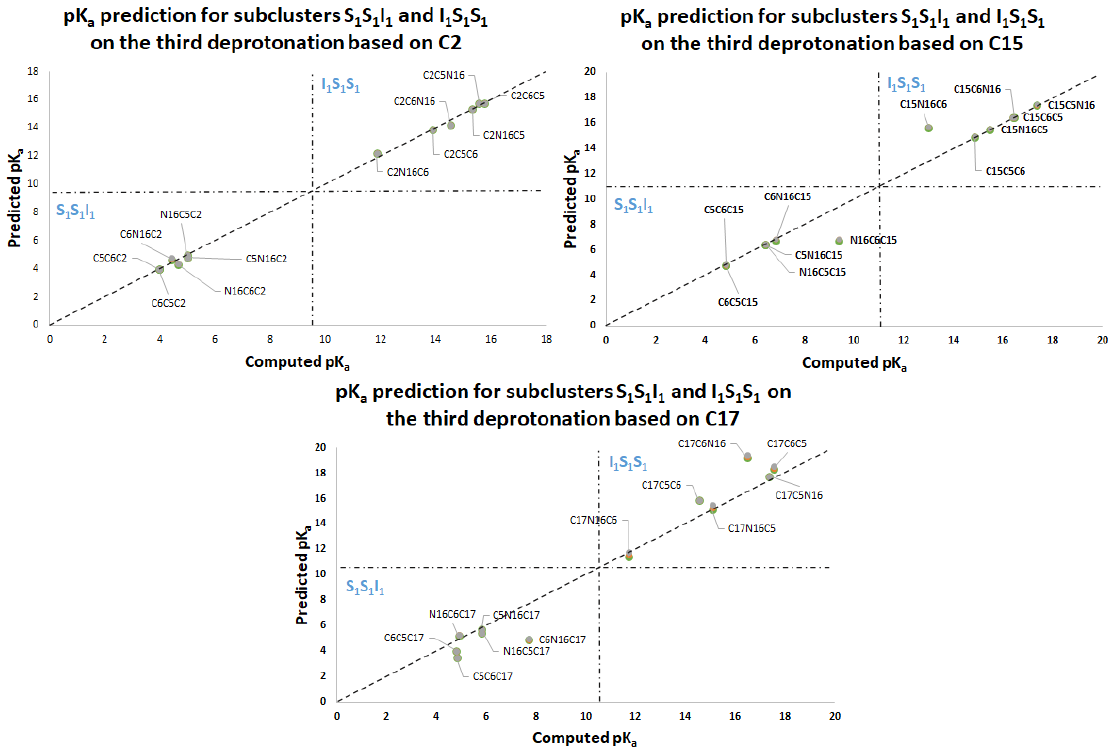
Figure 17. pK a prediction for the third deprotonation on the subclusters S 1 S 1 I 1 and I 1 S 1 S 1 based on C2, C15, and C17. Predictions are marked as gray (max), orange (mean), and green (min).